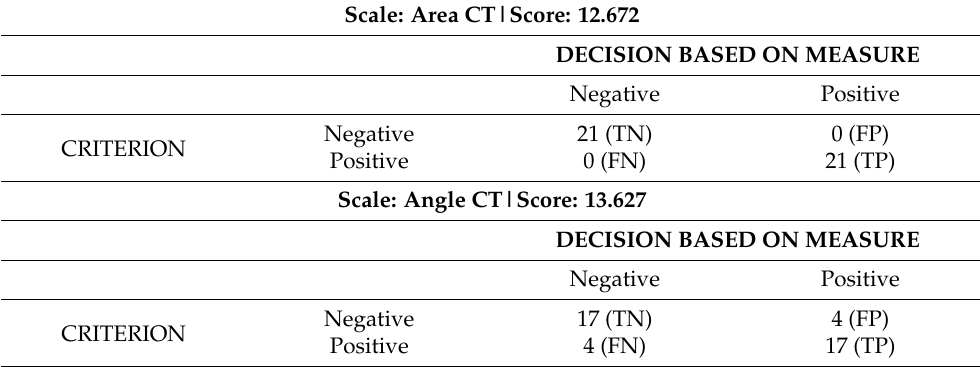
Table 4. Sensitivity and specificity table of the angle and the area score that gives the maximum true negative and the true positive values of the